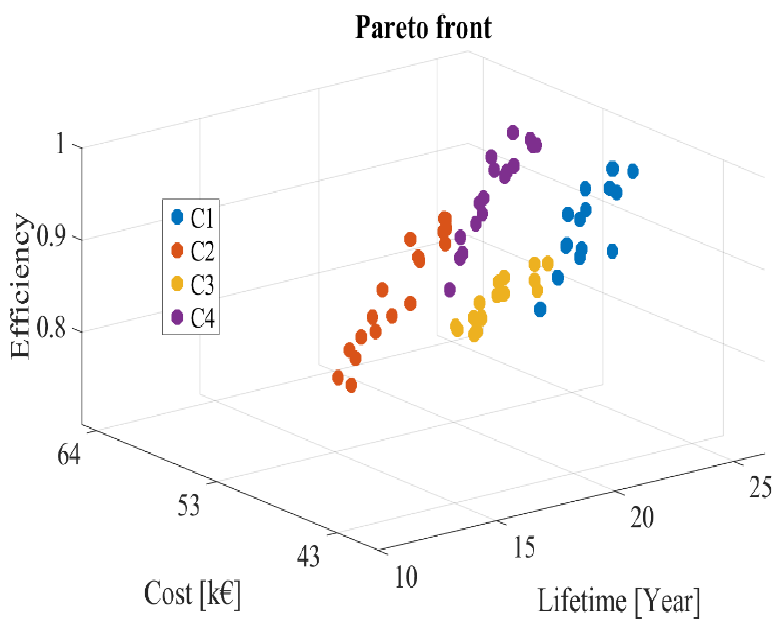
Table 6. Optimal hybrid system configuration solutions with the topology, TO-1. HBESS 𝑺𝒐𝒍 𝒏